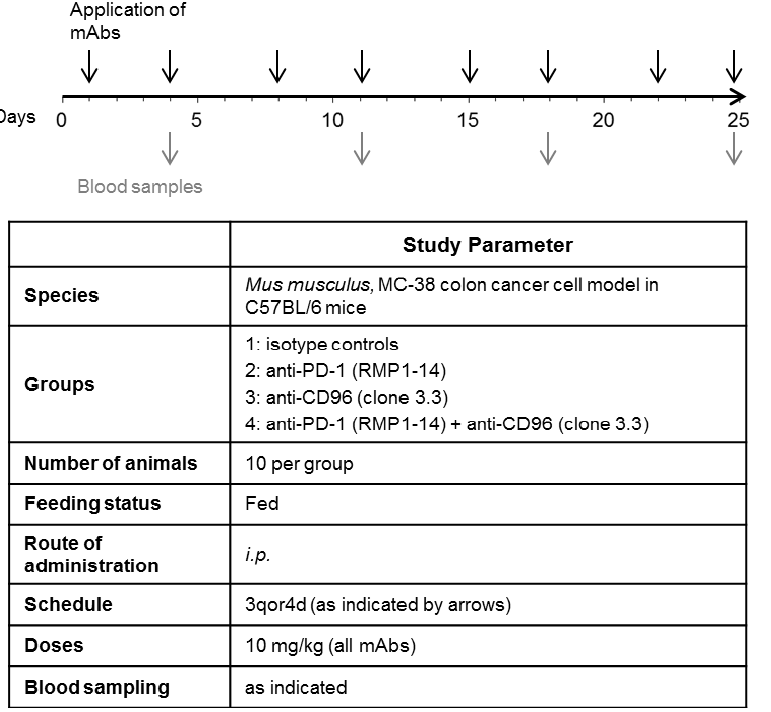
Figure 1. Experimental plan for testing the effect of anti-PD-1 and anti-CD96 antibodies on tumor growth in a mouse colon cancer model. C57/BL6 mice were transplanted with MC-38 colon carcinoma cells on day 0. Treatment with the antibodies was initiated on day 3, post transplantation. Black arrows indicate i.p. application of mAbs, each at 10 mg/kg. Gray arrows indicate drawing of blood samples.